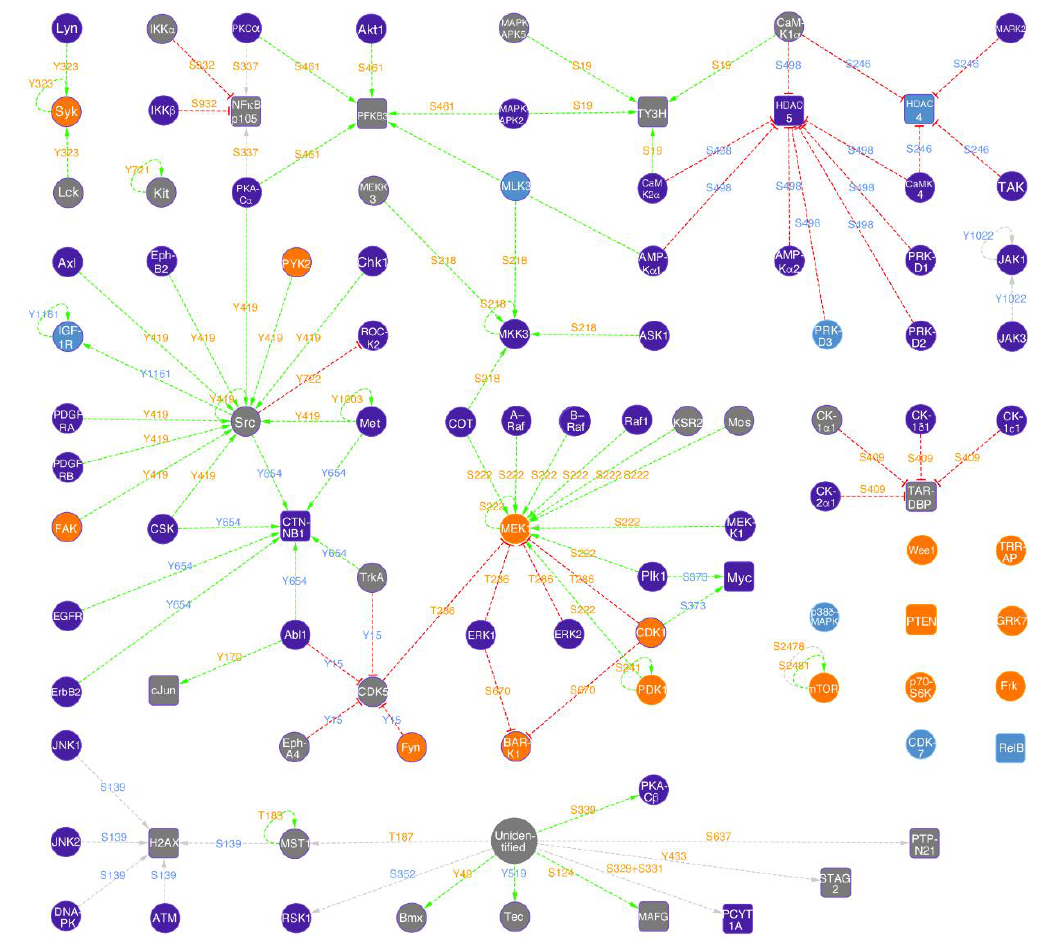
Figure 6. KiNetscape representation of norvaline treatment associated hippocampal signaling (qualitative map style). Protein kinases are represented with circular icons and other proteins with rounded box icons (nodes). Activating phosphorylation events are shown with green dotted lines and arrows, inhibitory phosphorylation with red dotted lines and phosphorylation with undefined effects with grey dotted lines (edges). Proteins that showed increased expression changes greater than 45% are colored orange, and appear blue if there was a decreased expression greater than 45%. Protein expression changes less than 45% are not identified and these protein icons are colored purple. If the phosphorylation of a site on a protein was induced by more than 45%, then the text for this phosphosite is colored orange. If its phosphorylation was reduced more than 45% in response to norvaline, the text is colored blue. Changes in phosphorylation less than 45% are not indicated and the text for these phosphosites appears grey. The appearance of a positive or negative sign in front of the phosphorylation site text indicates if the site is known to be stimulatory or inhibitory, respectively.